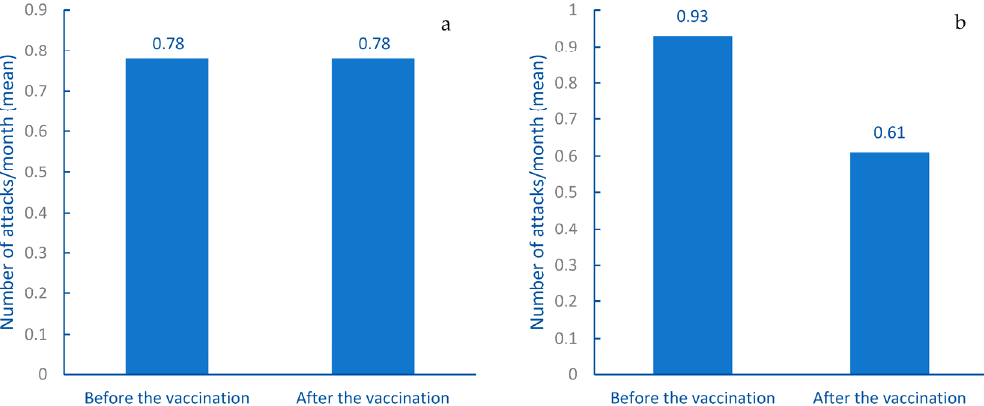
Figure 3. Difference of monthly attack rates between the six-month period before the vaccination and the six-month period after the vaccination in the study population: ( a ) attack rate in patients on on-demand therapy; ( b ) attack rate in patients on